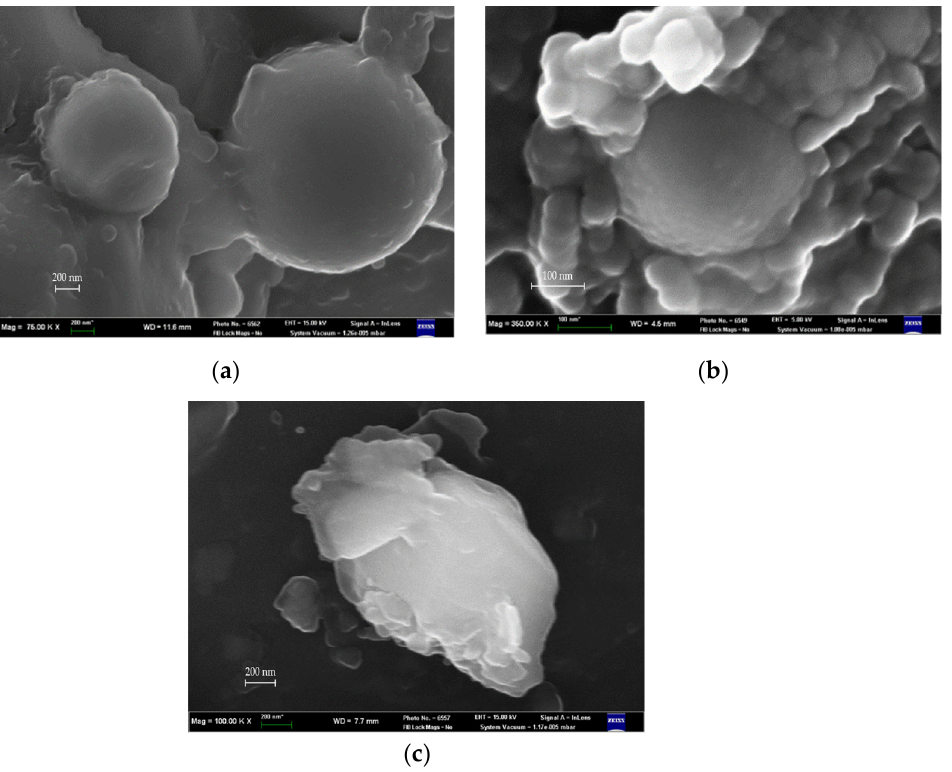
Figure 2. SEM-images of Al 2 O 3 -reinforced composite specimens: ( a ) the original particles, ( b , c ) coated particles.